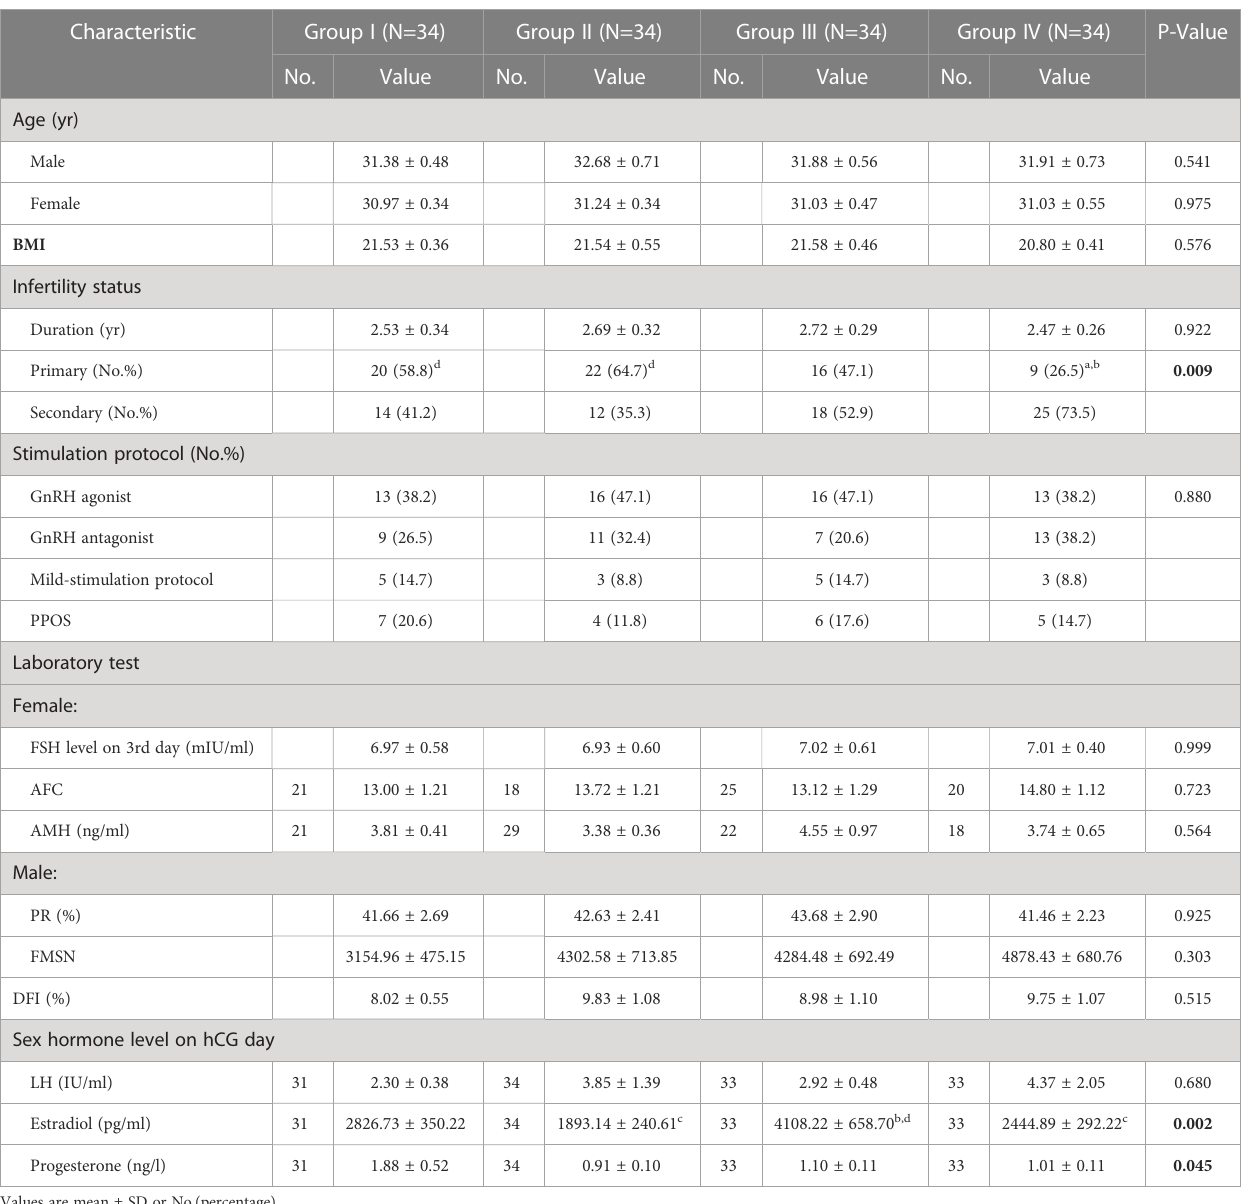
TABLE 1 Demographic and characteristics of